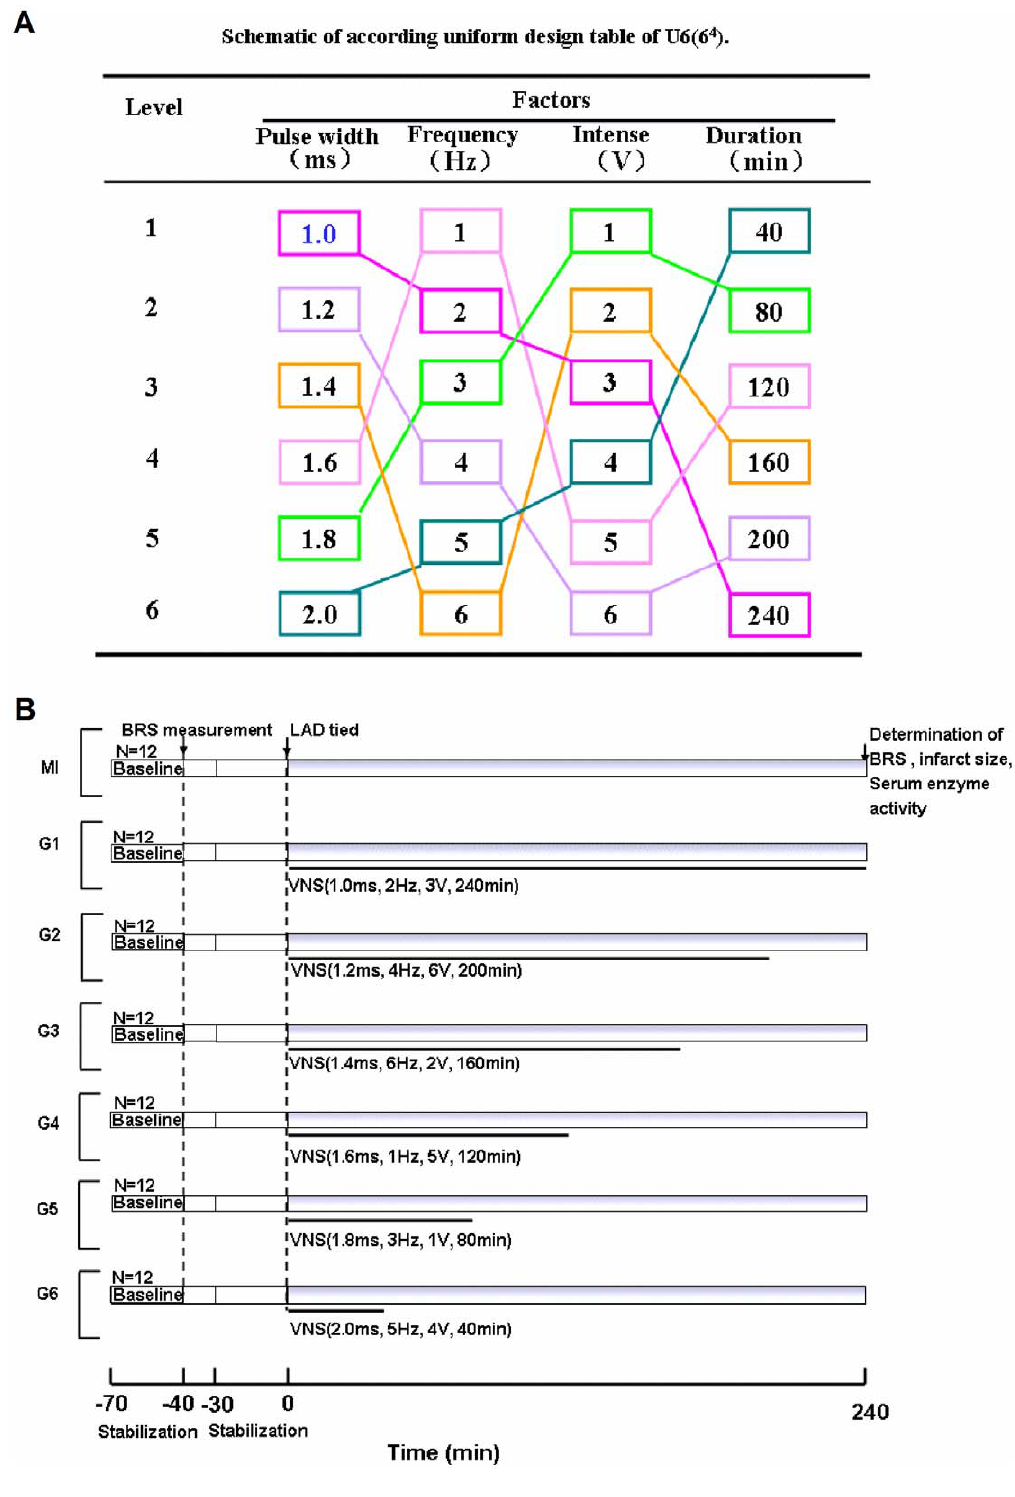
Figure 2. Uniform design protocol and schematic representation of the protocols of study. (A) Factors and levels in the uniform design experiments. (B) Experiment of protocol. After initial surgical preparation, all rats were allowed 30 minutes (min) stabilization. Rats in each group were then treated a bolus injection of phenylephrine (5 m g/kg, i.v.) via the right femoral vein to measure baroreflex sensitivity (BRS). After this, all rats wer e allowed to stabilize over a 30-minute period before left anterior descending (LAD) artery ligation. Acute myocardial infarction (AMI) was induced by 240 min of LAD artery ligation. In MI group, the rats were just received LAD without VNS. In the G1–G6 group, vagus nerve stimulation (VNS) was performed immediately after the LAD artery ligation. Different vagal stimulation parameters following LAD artery ligation was also demonstrated in experiment protocol.